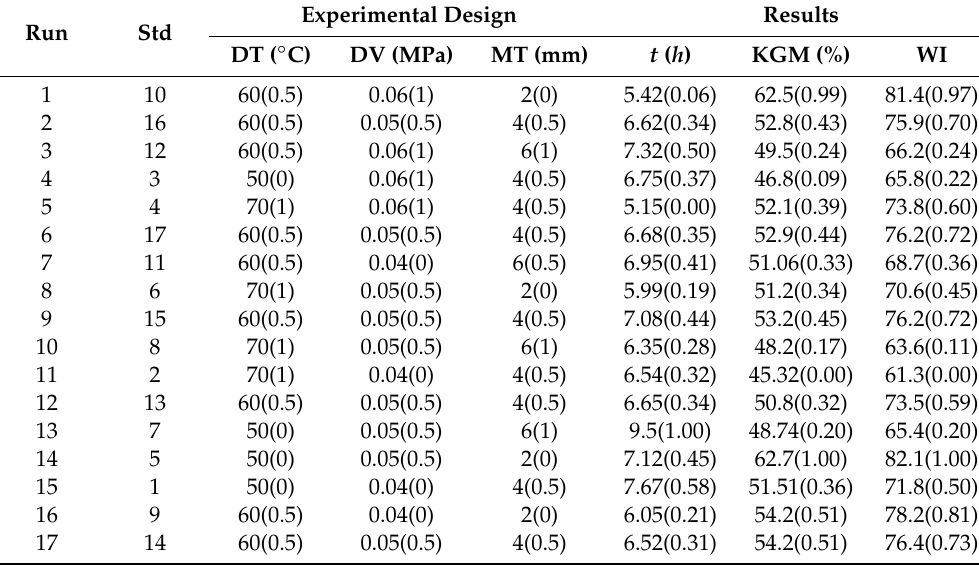
Table 2. Experimental values of response variables for Box–Behnken